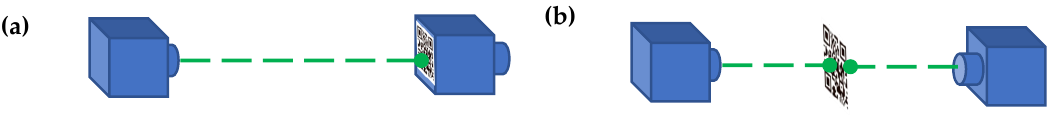
Figure 5. VOS single chain: ( a ) sensor to sensor; ( b ) sensor – target – sensor.